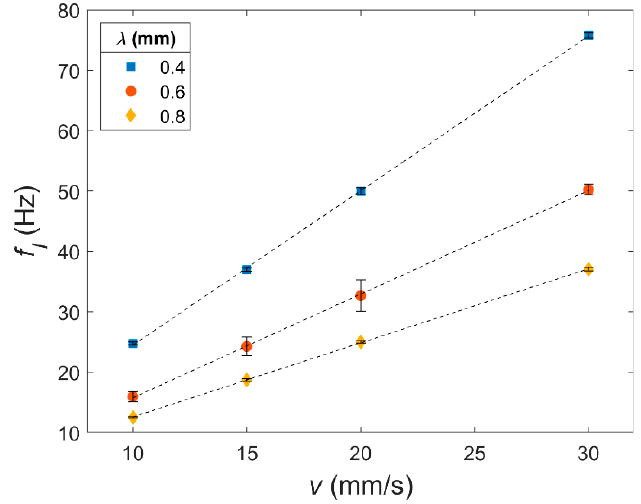
Figure 7. Linear fit (dashed lines) and experimental (filled squared markers) data of the first harmonic as a function of the scan velocity, for different grating spatial periodicities (error bar = standard deviation over 6 repetitions).